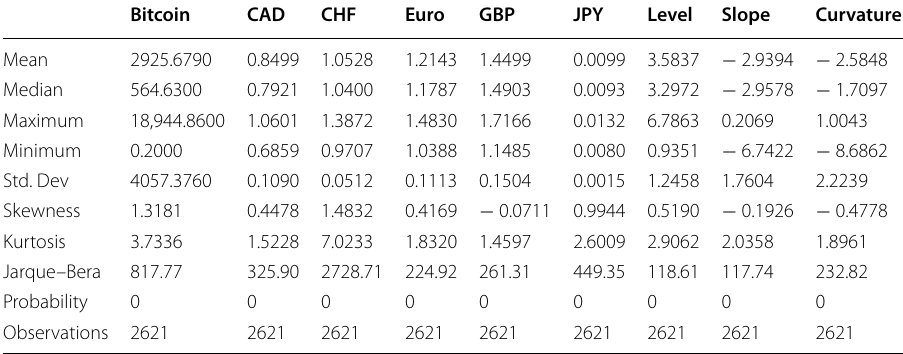
The table reports the descriptive statistics of the exchange rates of five major safe haven currencies (CAD CHF Swiss Franc, GBP Great British Pound, JPY Japanese Yen) and Bitcoin as well as the three components of the US = = = yield curve (Level, Slope and